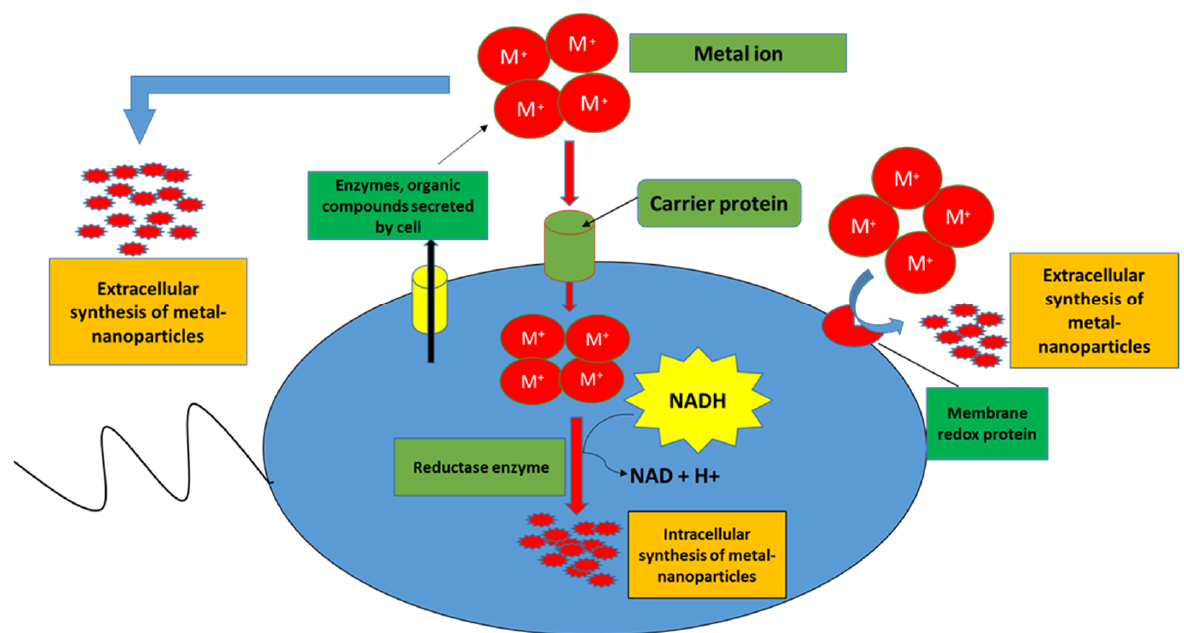
Figure 1. Intra-and extracellular biosynthesis of metal-nanoparticles by Bacillus spp. Extracellular biosynthesis of metal-nanoparticles is carried out by trapping metal ions on the cell surface and reducing them in the presence of secreted enzymes or metabolite and/or membrane-bound enzymes. In the intracellular biosynthesis of metal-nanoparticles, after transfer of metal ions into cell cytoplasm, dependent nitrate